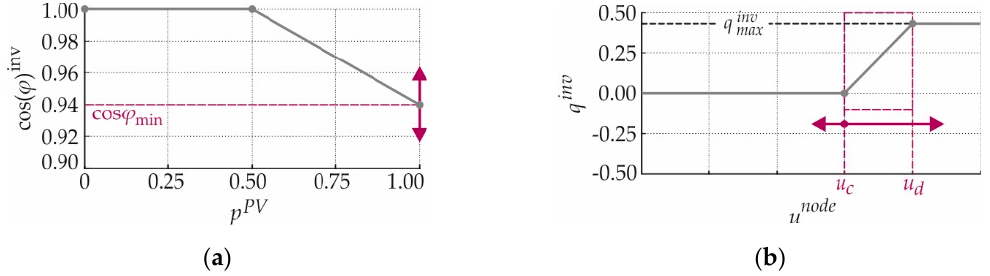
Figure 6. Methodology to parameterize different local control strategies for PV-inverters: (a) cos φ ( P )-control; (b) Q ( U )-control.